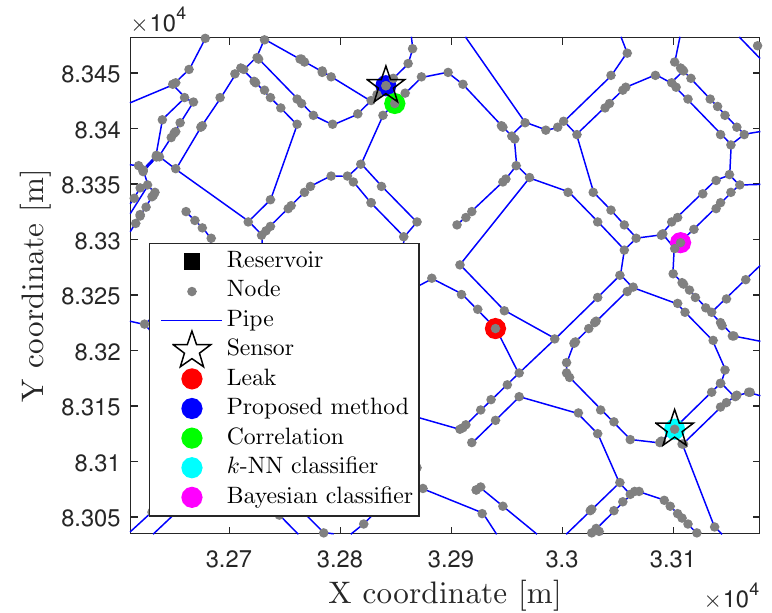
Figure 10. Nova Icària leak localization results.